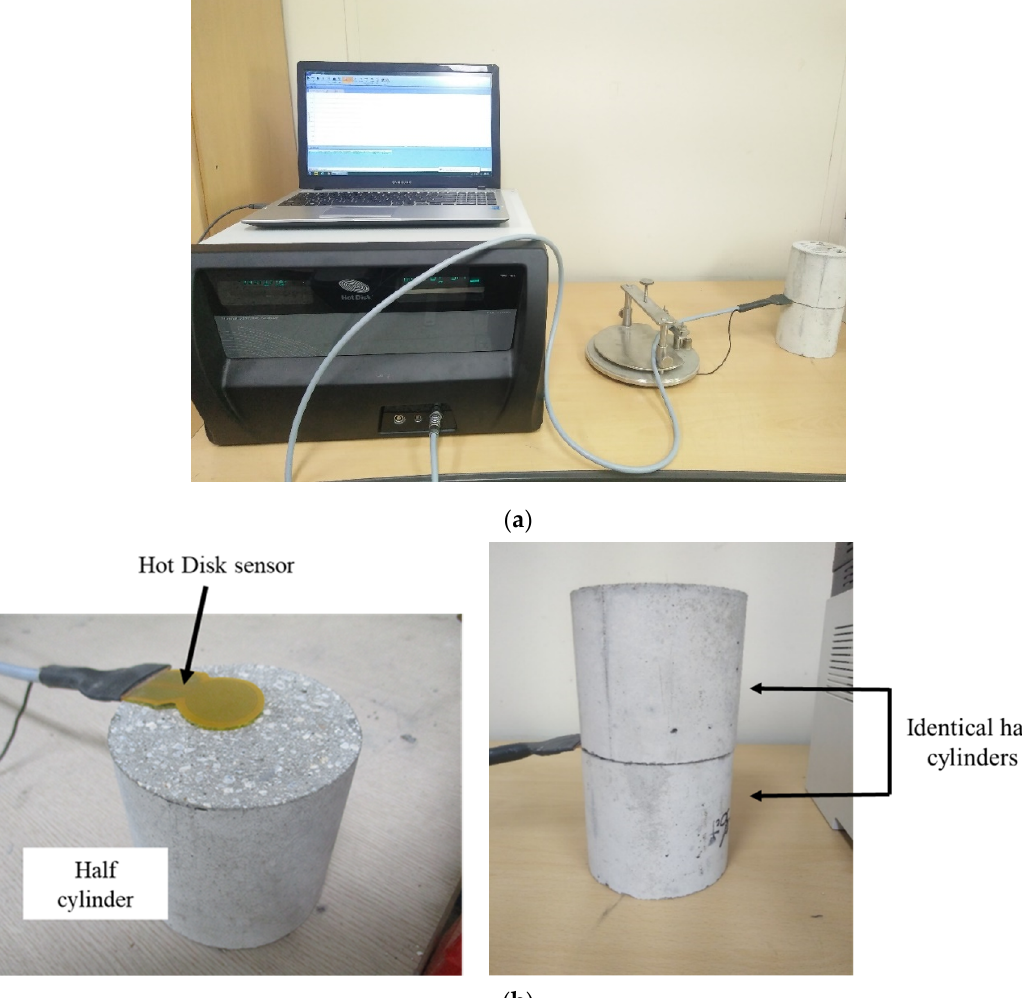
Figure 4. Test setup for the thermal conductivity measurements. ( a ) Transient plane source (TPS) measurement system; ( b ) concrete specimens used for the thermal conductivity experiments.